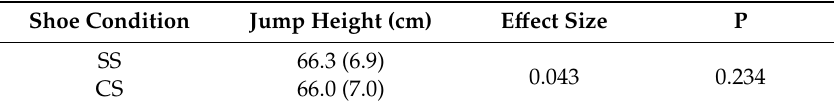
Table 1. Mean (SD) jump height during LJs (n =